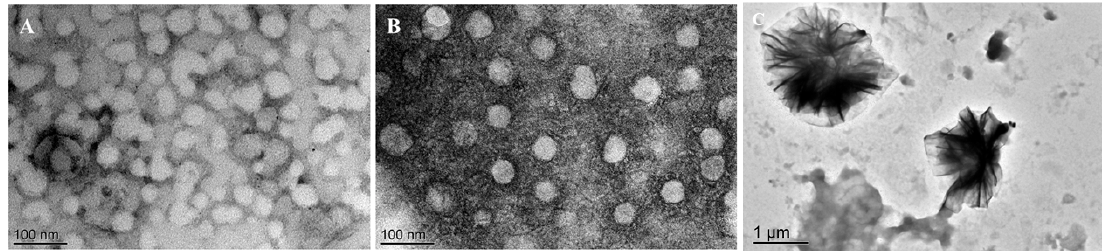
Figure 5. Transmission electron microscopy (TEM) images of blank ( A ), DOX-loaded ( B ), pH and near infrared light stimulated ( C ) mPEG-PEI-(NBS, OA) upconversion